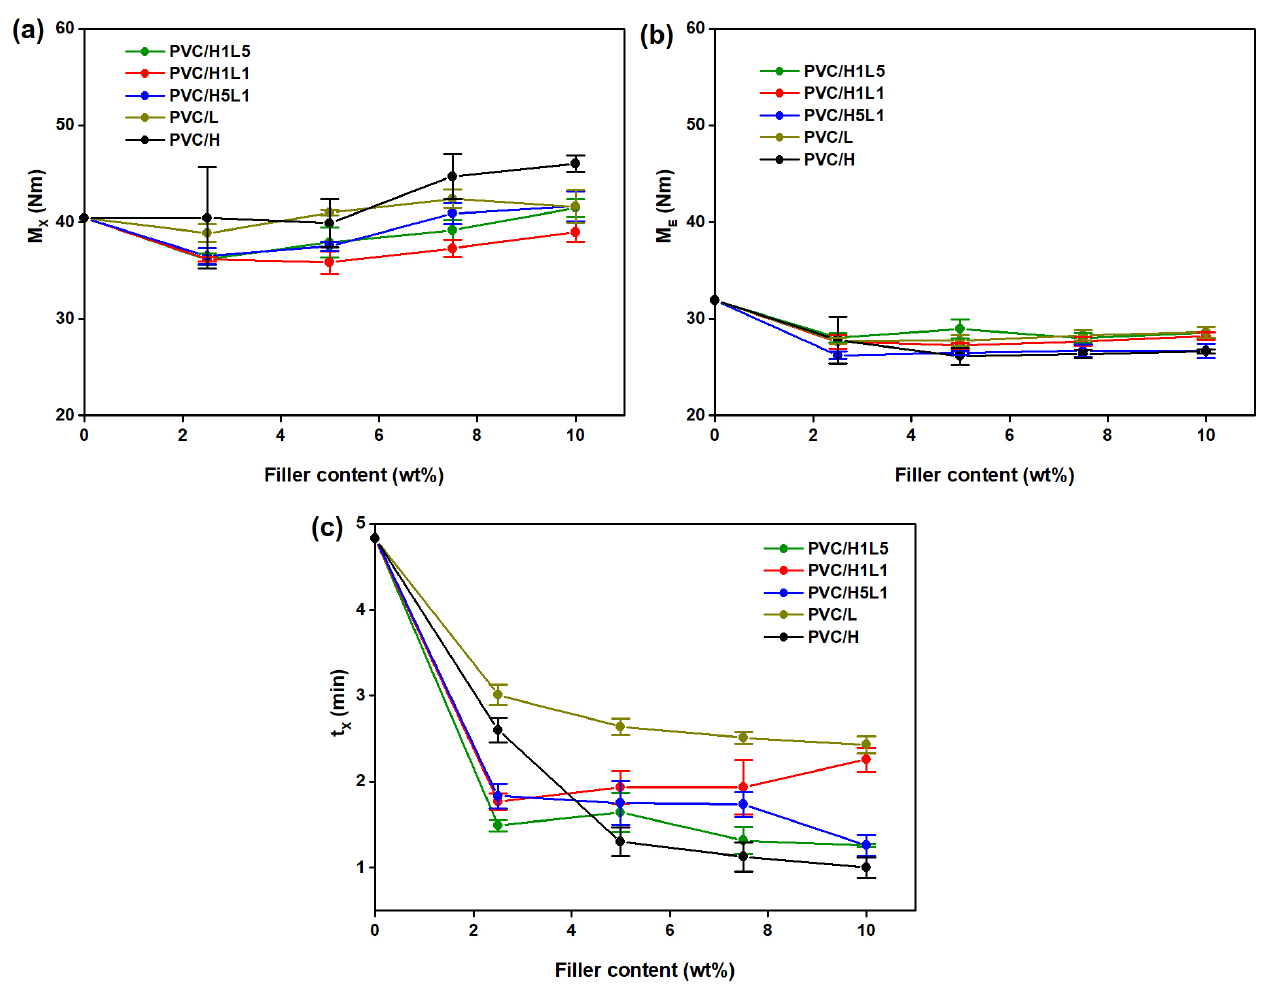
Figure 3. The fusion properties of the PVC composites: ( a ) maximum value of torque (M X ), ( b ) values of torque at the end point of plastograms (M E ) and ( c ) time required to reach the M X (t X ), as a function of filler content.